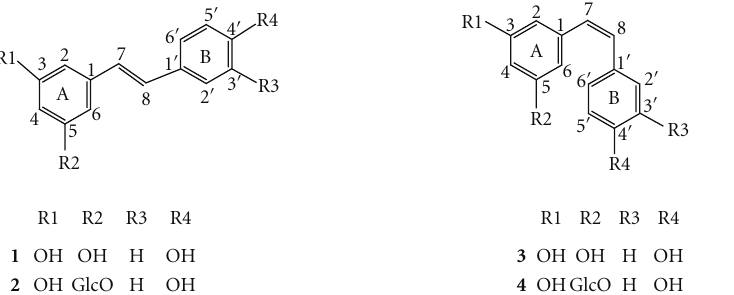
Figure 1: Molecular structures of trans - and cis -resveratrol 1 and 3, and trans - and cis -piceid, 2 and 4, respectively (GlcO = β -D-glucose).